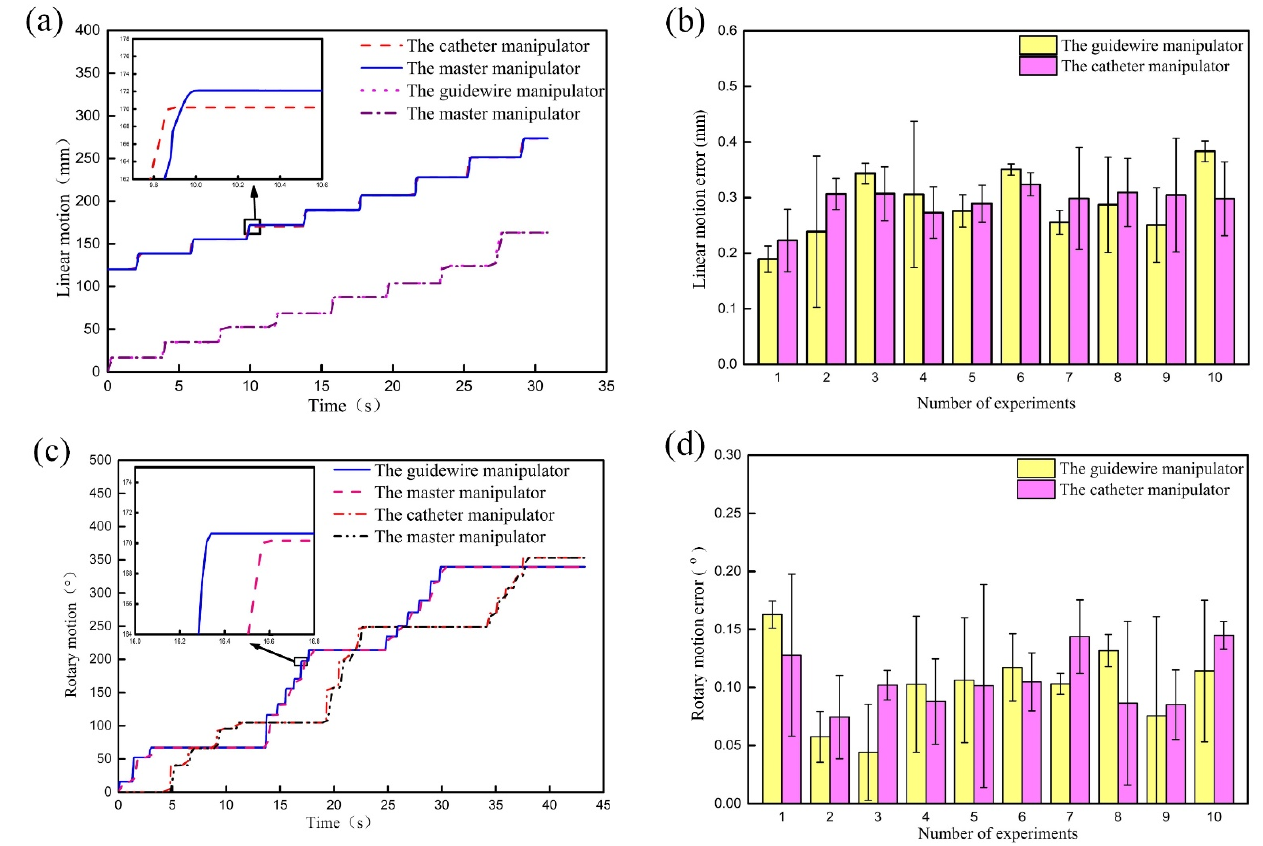
Figure 11. Tracking trajectories and tracking errors of linear motion ( a , b ) and rotary motion ( c , d ) during cooperation.